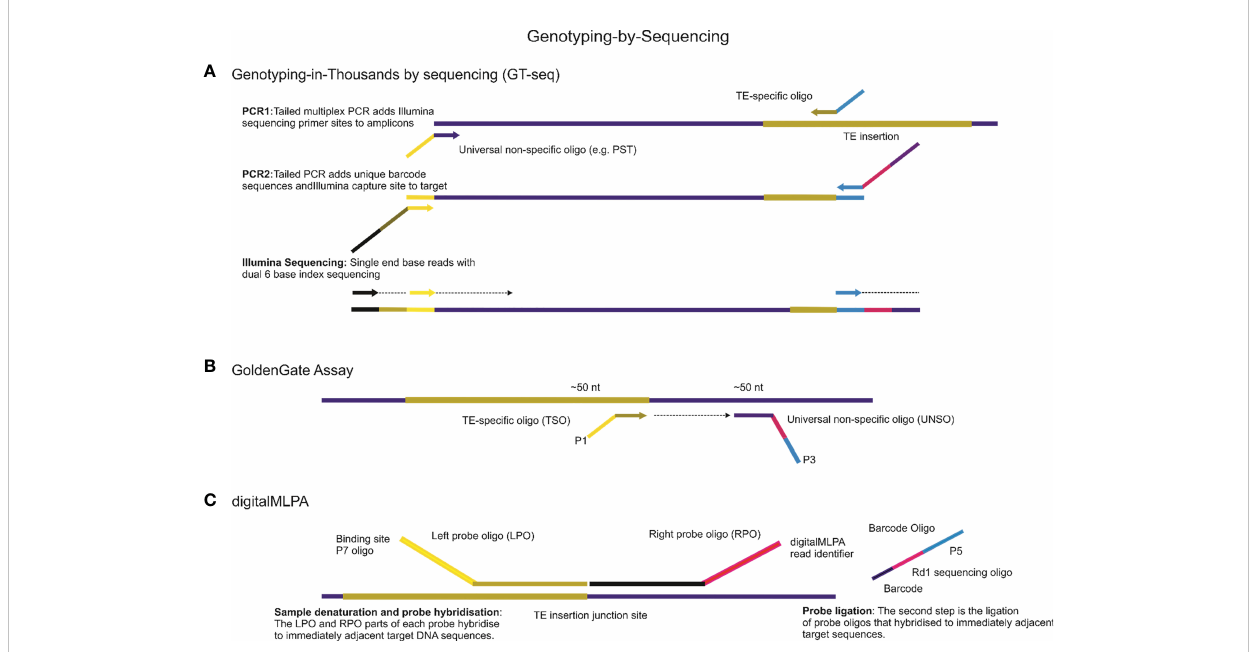
FIGURE 3 Genotyping-by-Sequencing (GBS) is a powerful technique for detecting genetic variations using Next-Generation Sequencing (NGS) platforms. This technique has several approaches, some of which are highlighted below. (A) . One such approach is Genotyping-in-Thousands by sequencing (GT-seq), which uses NGS of multiplex PCR amplicons to produce genotypes from a small panel of mobile element insertions for thousands of individuals on Illumina NGS platforms. The basic principles and steps involved in this technology are also applicable to other NGS applications. (B) Another approach is the GoldenGate Assay, which can be designed for genotyping mobile element insertion sites involving a high degree of loci multiplexing (1536-plex). For all mobile element insertions sites, two oligonucleotides are designed, one is TE-speci fi c to the mobile element site, called TE-Speci fi c Oligos (TSO), and the second oligo, called the Universal Non-Speci fi c Oligo (UNSO), for example, a universal primer able to anneal to palindromic sequences (PST), hybridizes downstream from the TE site. All oligonucleotides contain regions of genomic complementarity and universal PCR primer sites, while the UNSO also has a unique address sequence that targets a particular bead type. The extension of the appropriate TSO and ligation of the extended product to the UNSO join the genotype present at the TE site to the address sequence on the UNSO. (C) digitalMLPA is a semi-quantitative technology that is used to detect relative copy number variation and identify speci fi c polymorphisms. With digitalMLPA, up to 1000 target sequences can be identi fi ed in a single multiplex PCR-based